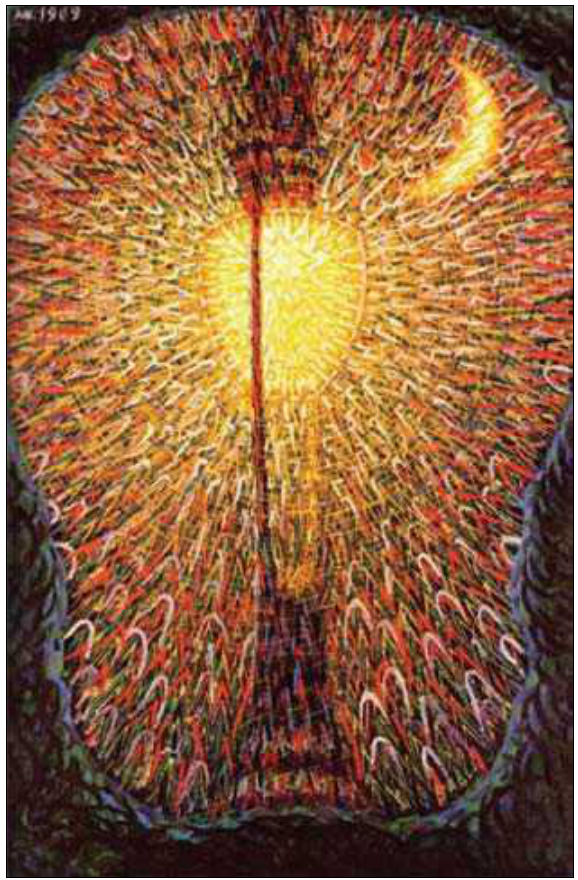
Fig. 2. Lampada ad arco (arch. Giacomo balla),